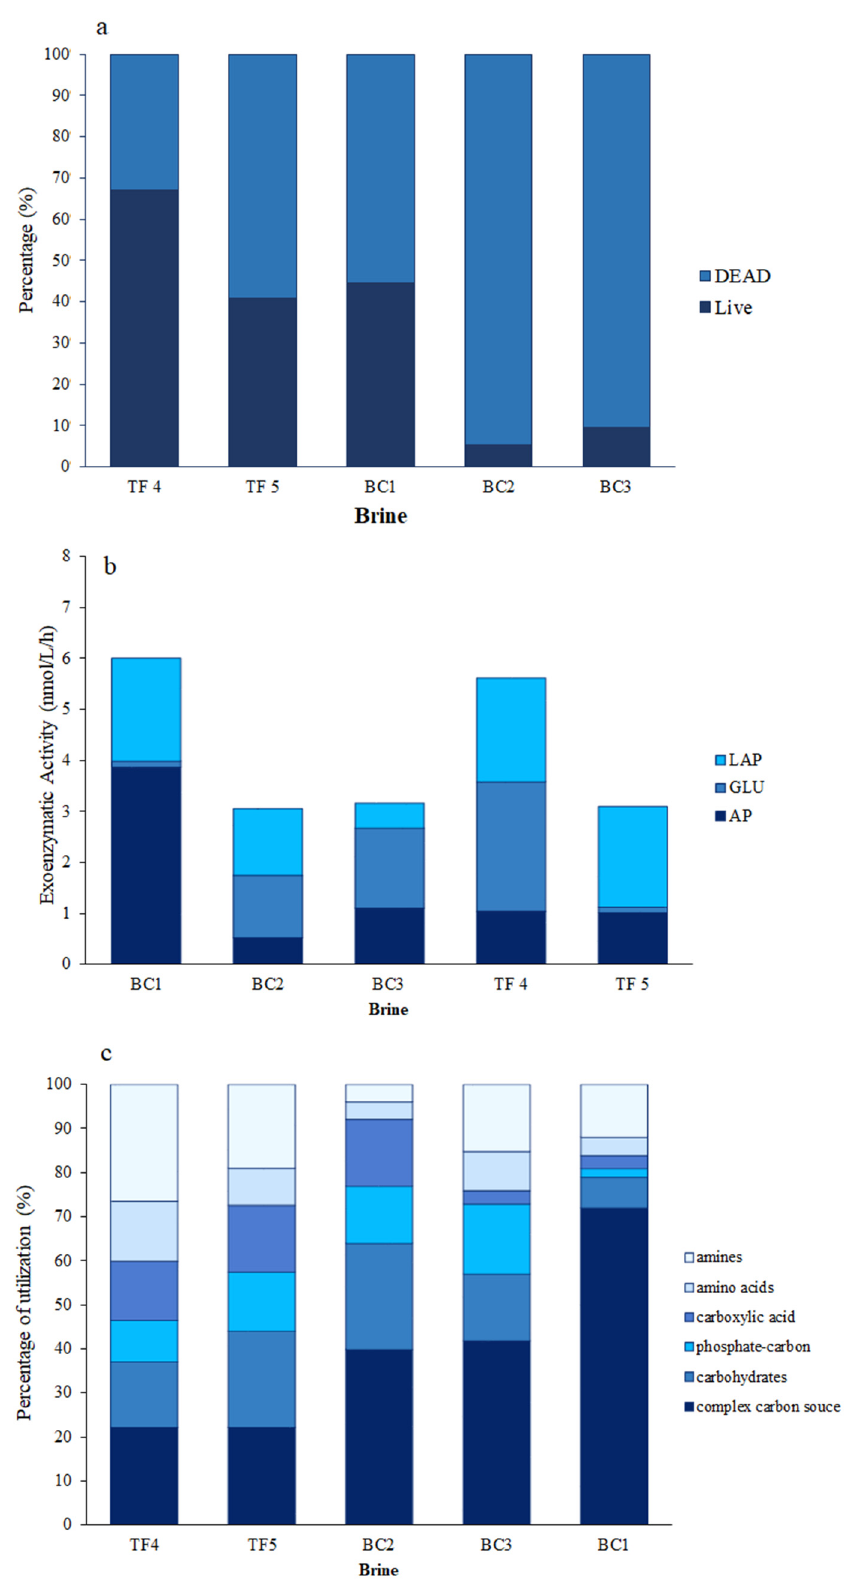
Figure 1. Microbial abundance and activities: ( a ) Viable (live/dead) cells in brine samples; ( b ) enzymatic activities measured in brine samples; ( c ) percentages of carbon source utilization obtained by Biolog Ecoplate.